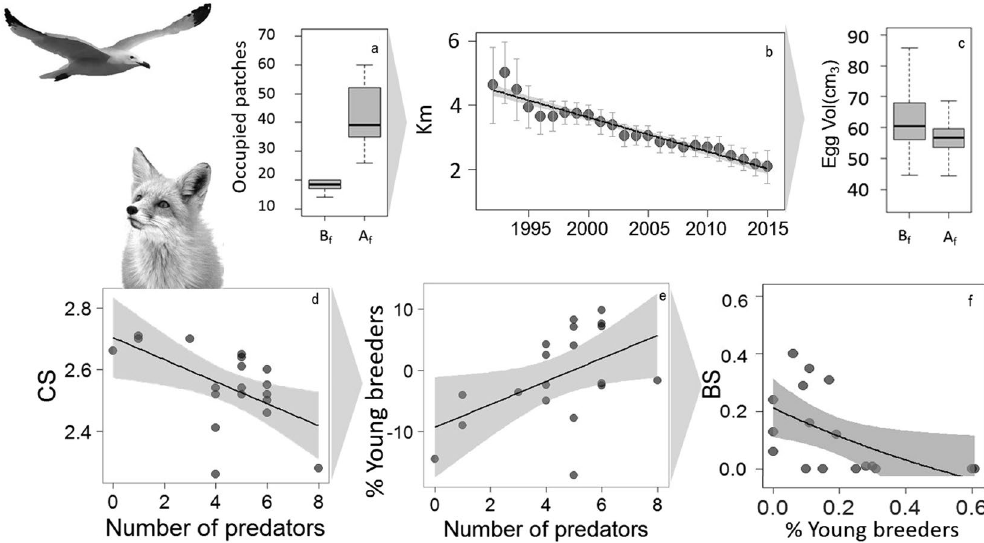
Figure 2. Non-lethal effects of predator presence in the Audouin’s gull breeding colony (Ebro Delta, Spain). ( a ) Changes in number of occupied patches before, B f , and after, A f , predators entered the colony. ( b ) Temporal evolution (1992-2015) of the mean distance ( ± 1.96 SE) between the breeding area centroid and the eastermost point of the Ebro Delta colony (40.59 N, 0.71E). ( c ) Egg volume, Egg Vol before, B f , and after, A f , predators entered the colony. ( d ) Mean clutch size, CS and ( e ) proportion of young and inexperienced breeders in relation to the number of predators (relative difference between the observed and expected young and experienced breeders, positive numbers indicate lower proportions of experienced breeders as expected). Relationship between breeding success and % of young breeders, example from the year 2012 ( f ). Audouin gull modified from authors own photo. Fox modified from photo “Redfox10”. ©Cadigan. 2014: https://flic.kr/p/kFvEbZ. The images can be used under a CC by 2.0 https://creativecommons.org/licenses/by/2.0/.